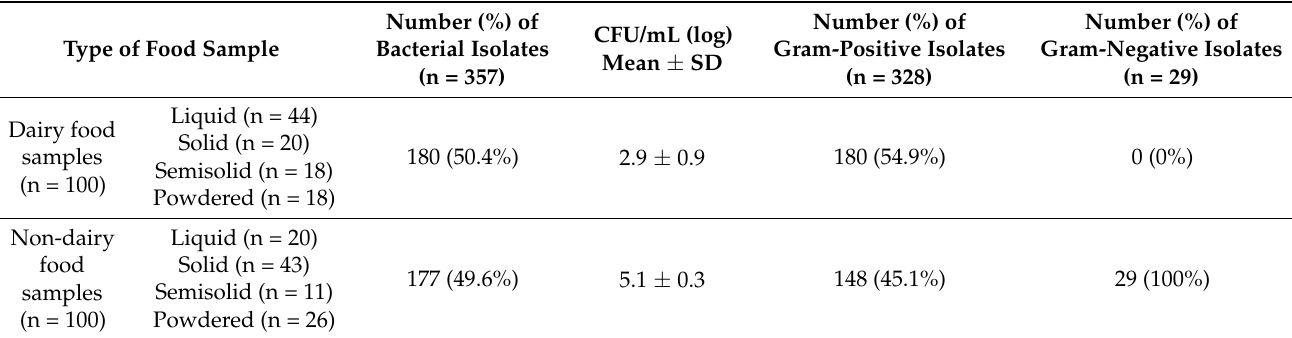
Table 1. Types of food samples and the microbial count of each food source (n = 200).